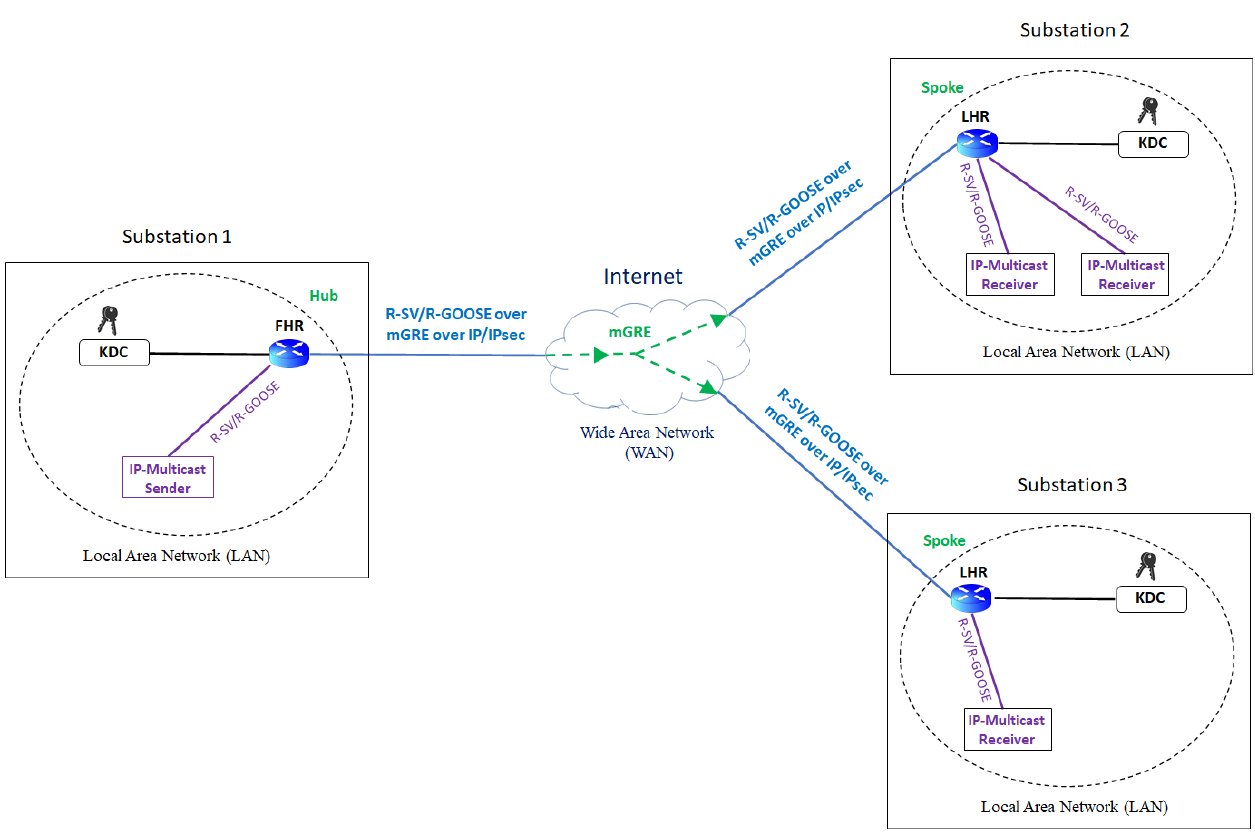
Figure 18. P2M architecture for multicast R-SV/R-GOOSE over public WAN (Internet) with mGRE within DMVPN.